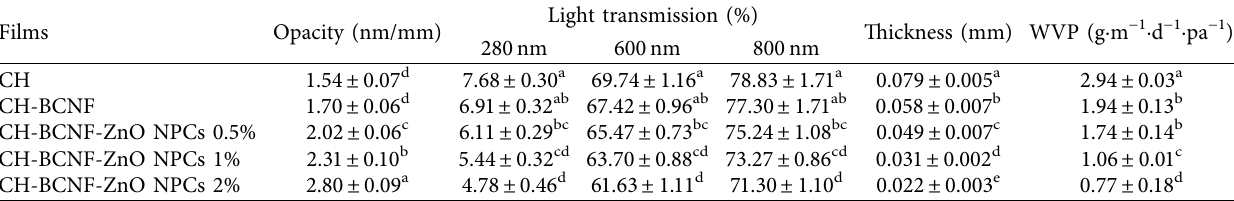
Table 1: Physical properties of the flms.